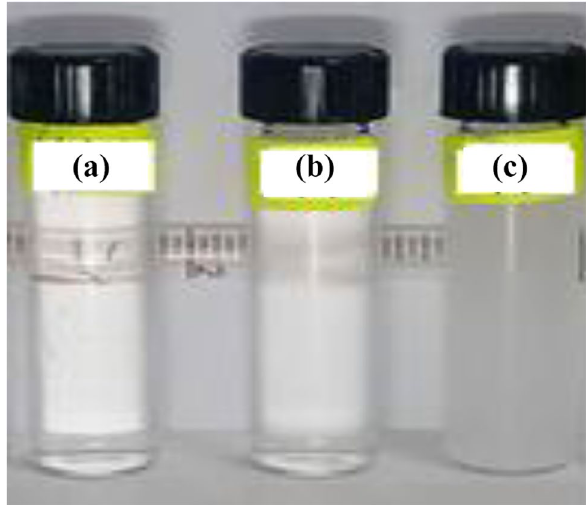
Fig. 1 Results of surfactant aqueous solution stability, a a clear stable solution, b a slightly blurry solution, c a cloudy/precipitated solution Fig. 2 Schematic diagram of Foamscan apparatus (Jones et al.